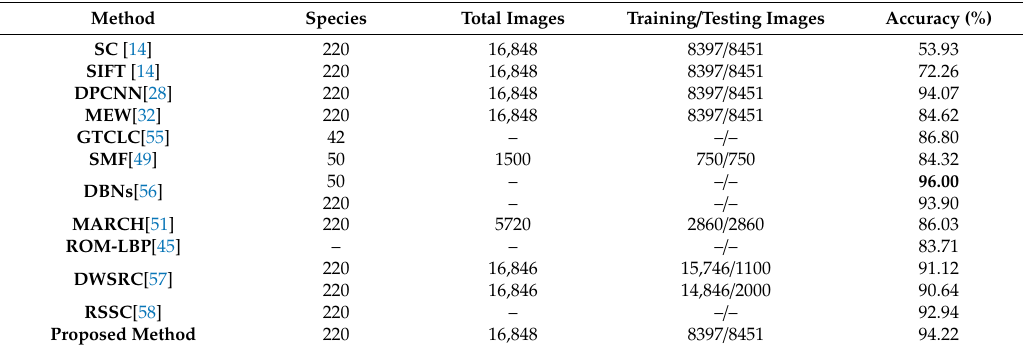
Table 5. Comparison of proposed method with existing approaches on ICL dataset.